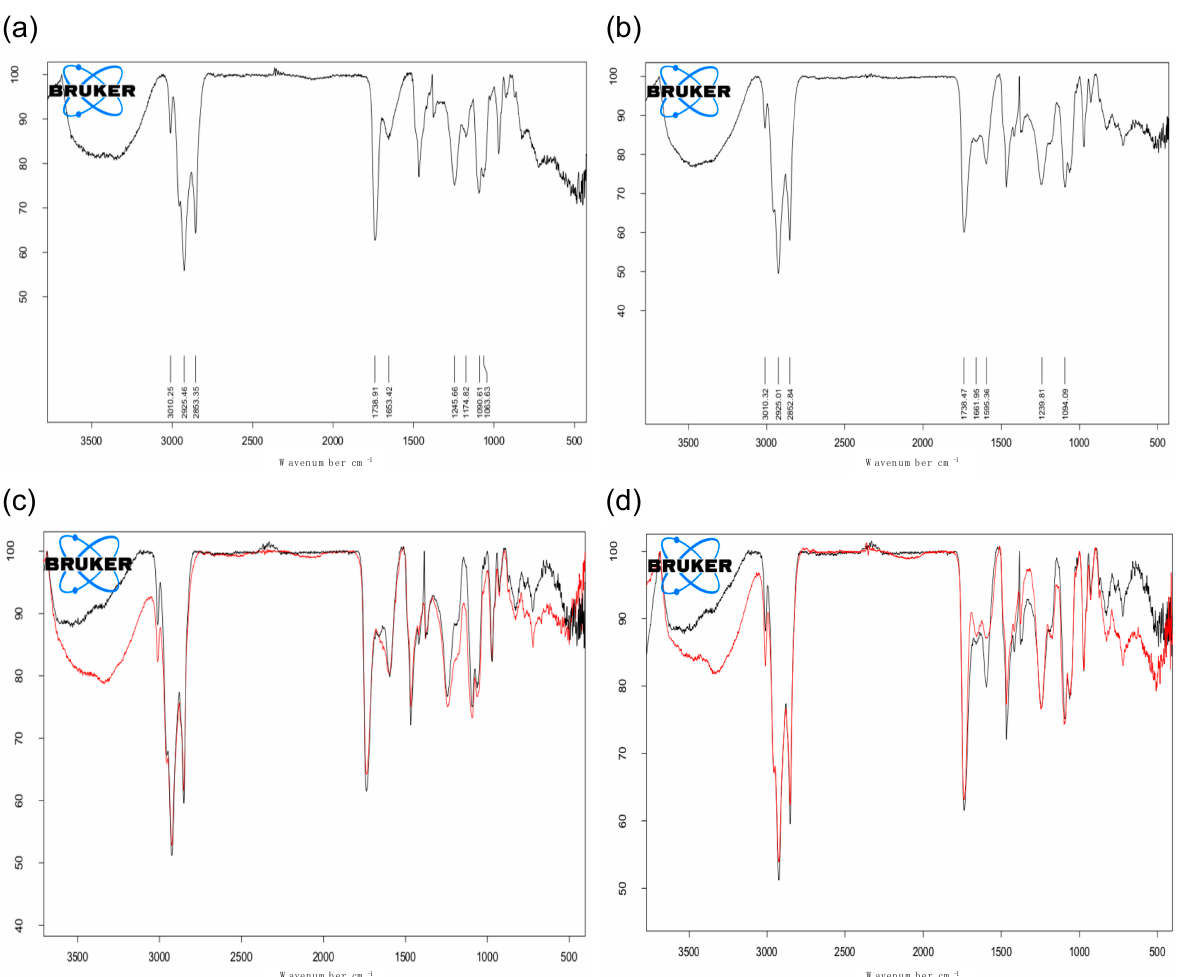
Figure 8. FT-IR spectra of plain-LP ( a ), LP-SLL ( b ), LP-SLL (black) overlapped to LP-SLL-MC (red) ( c ) and LP-SLL (black) overlapped to LP-SLL-MA (red) ( d ).